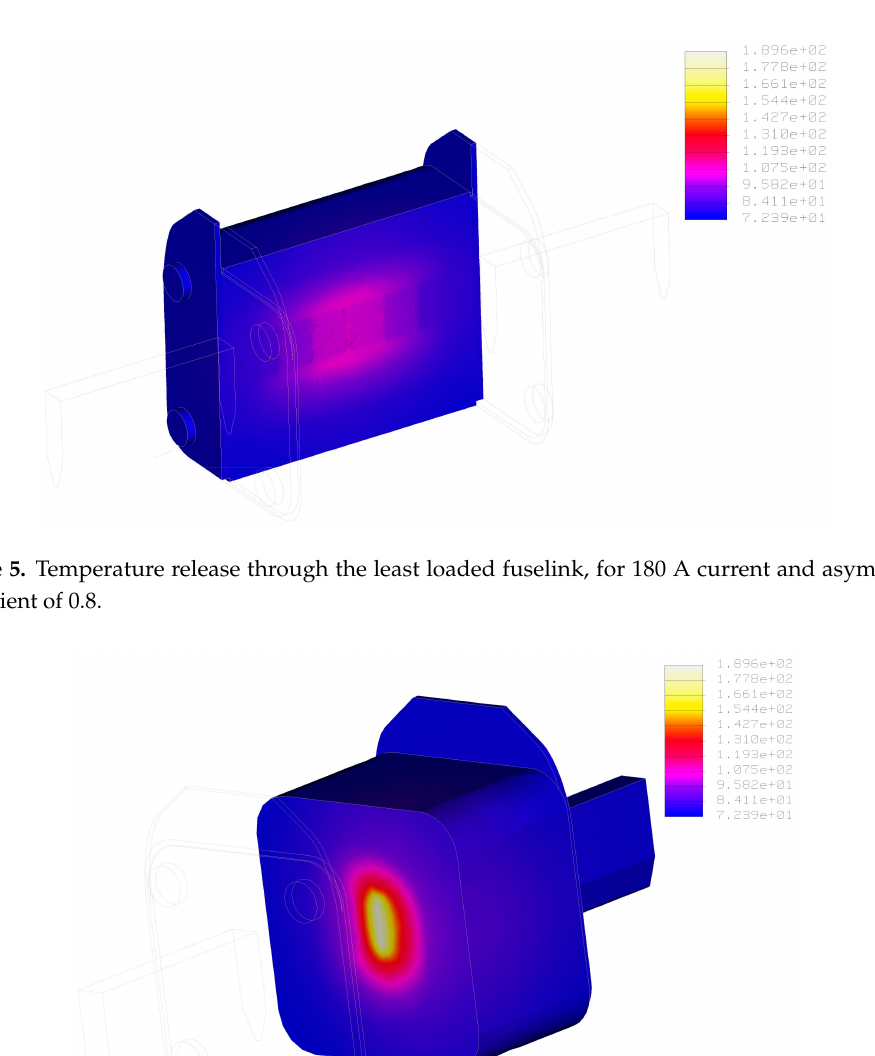
Figure 4. Temperature release through the most loaded fuselink, for 180 A current and asymmetry coefficient of 0.8.